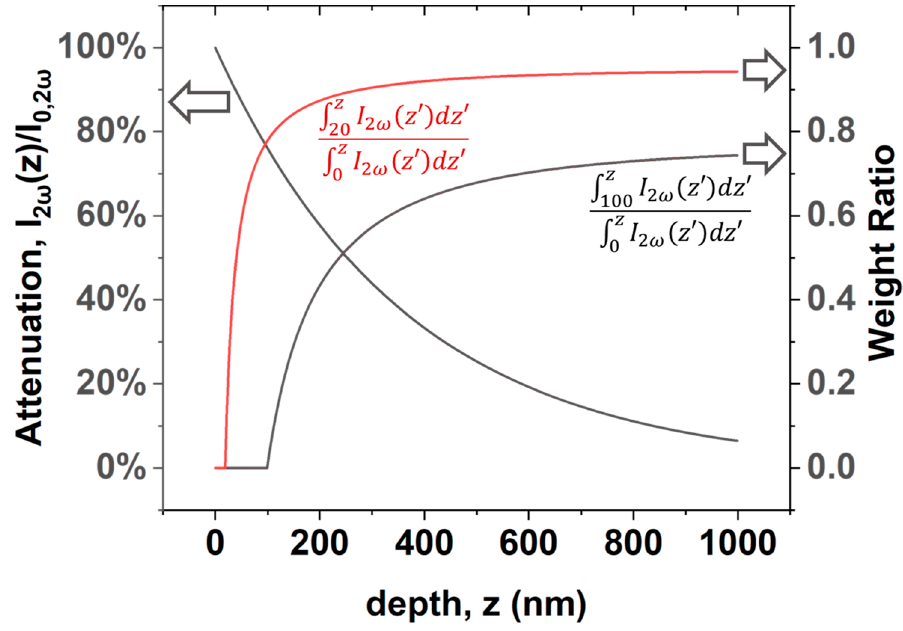
Figure 11. Attenuation and weight ratio of SHG contribution as functions to depth.